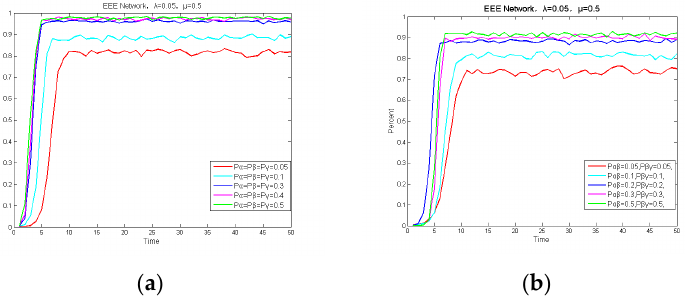
Figure 6. The spreading trends of three kinds of three-layer complex network under the same aver- age degree.